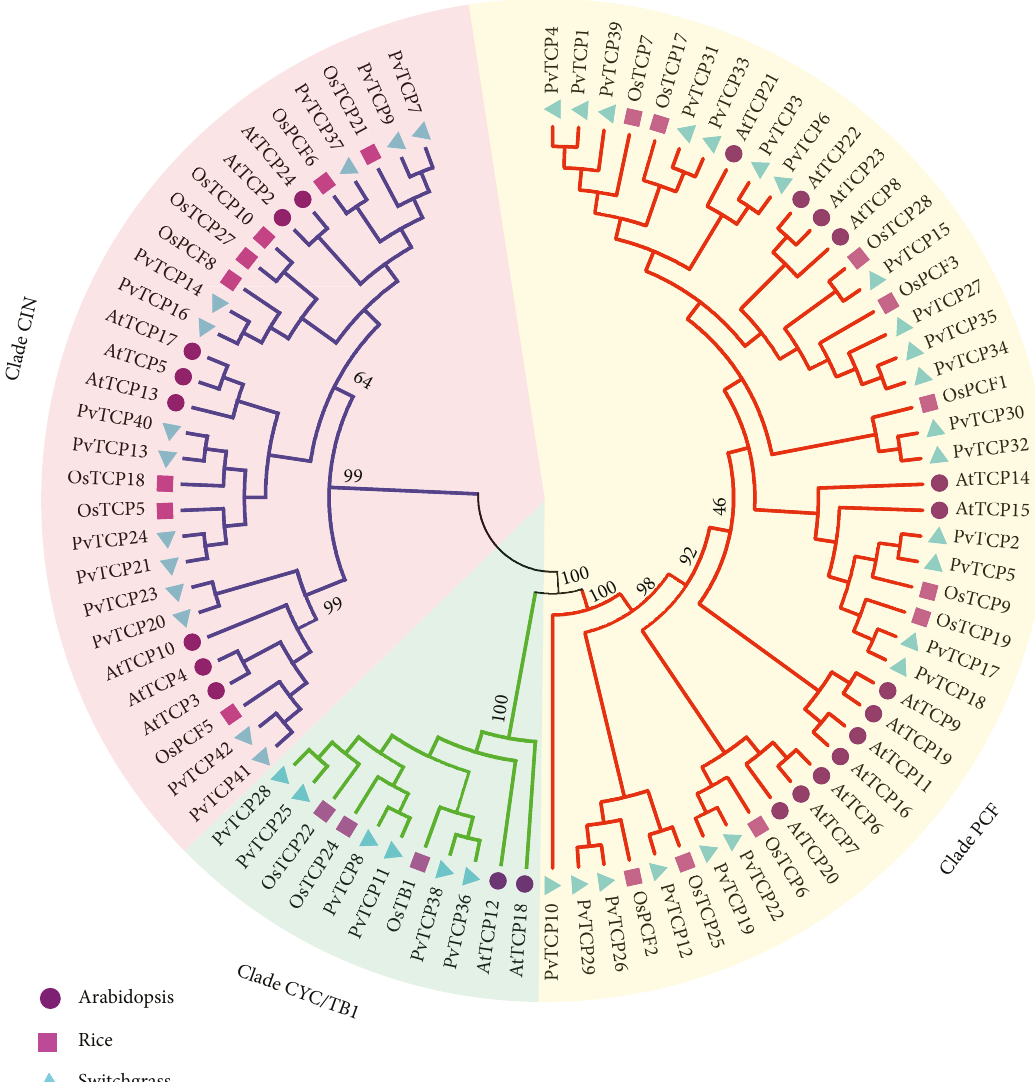
Figure 2: Phylogenetic analysis of TCP proteins in switchgrass, Arabidopsis , and rice. An unrooted neighbor-joining (NJ) tree was constructed using MEGA5.0 (bootstrap value = 1,000 ) after the multiple alignment of peptide sequences. All sequences used in this project were retrieved from the public genome database Phytozome v12.0 (https://phytozome.jgi.doe.gov/pz/portal.html#). The detailed information was listed in Table